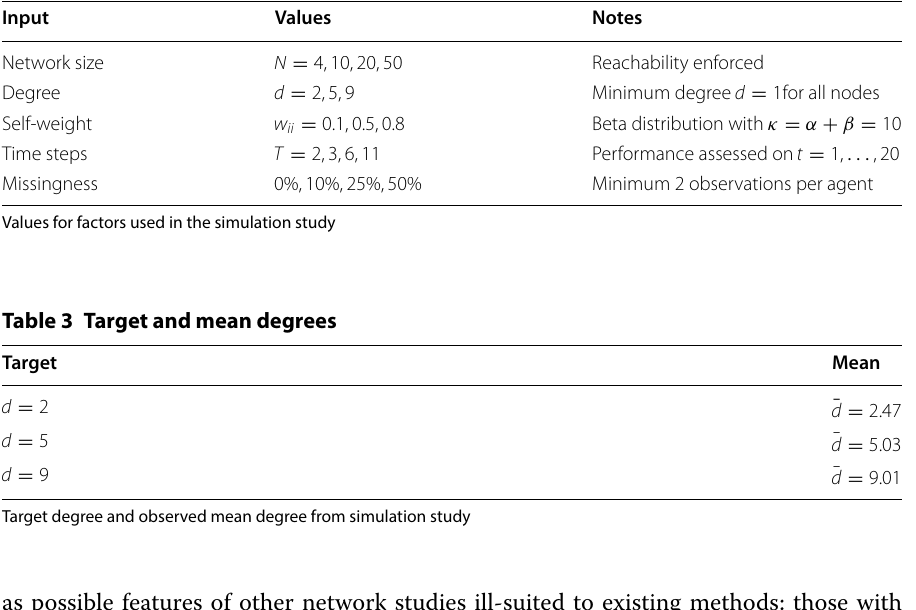
Table 2 Simulation study inputs